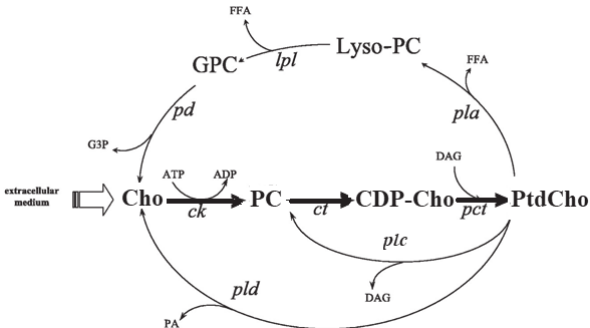
Figure 1. Kennedy pathway (center bold pathway) showing biosyn- thesis of the main PtdCho component of mammalian cell mem- branes from PC and the break-down pathway to glycerophospho- choline (GPC). A parallel pathway exists for PtdEth. 30 The enzymes involved in the pathways are shown in italics. Abbreviations: CDP- Cho , Cytidine diphosphate-choline; Cho , choline; ck , Choline Kinase; ct , Cytidylyltransferase; DAG , Diacylglycerol; FFA , Free fatty acid; G3P , Glyerol-3-phosphate; GPC , Glycerophosphocho- line; lpl , Lysophospholipase; Lyso-PC , Lysophosphocholine; PA , Phosphatidic acid; pct , Phosphocholine transferase; pd , Phosphodi- esterase; pla , Phospholipase A; plc , Phospholipase C; pld , Phospho- lipase